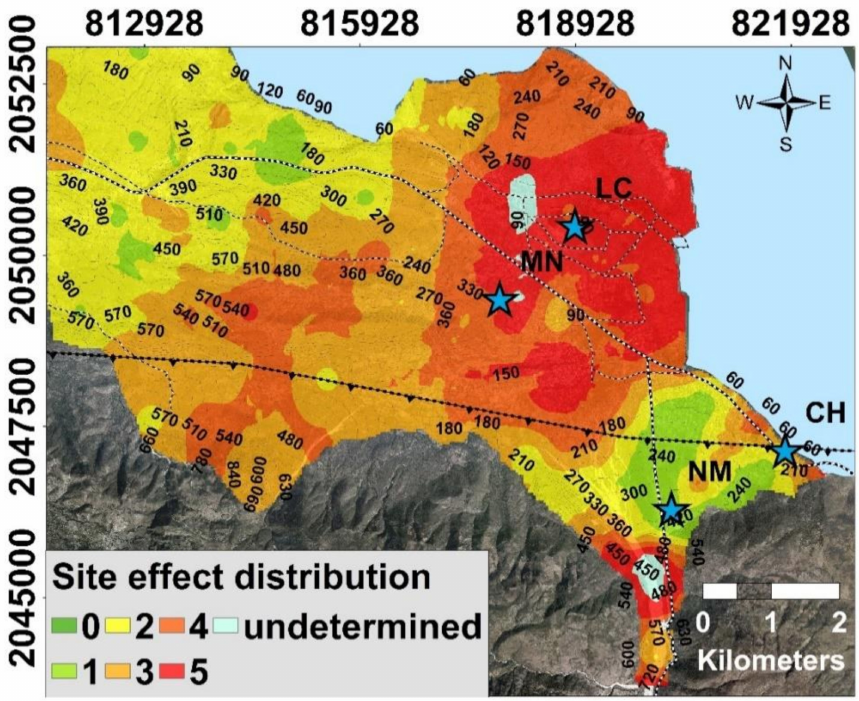
Figure 18. Map of the site effect distribution levels (0–1 represent no or very weak site effects, 4 to 5 marking strong site effects) in Fond Parisien. The classification is based on Equation. 1, and outlined in Tables 3 and 4. Table 2. Classes of values defined for the different parameters with their respective reference number.